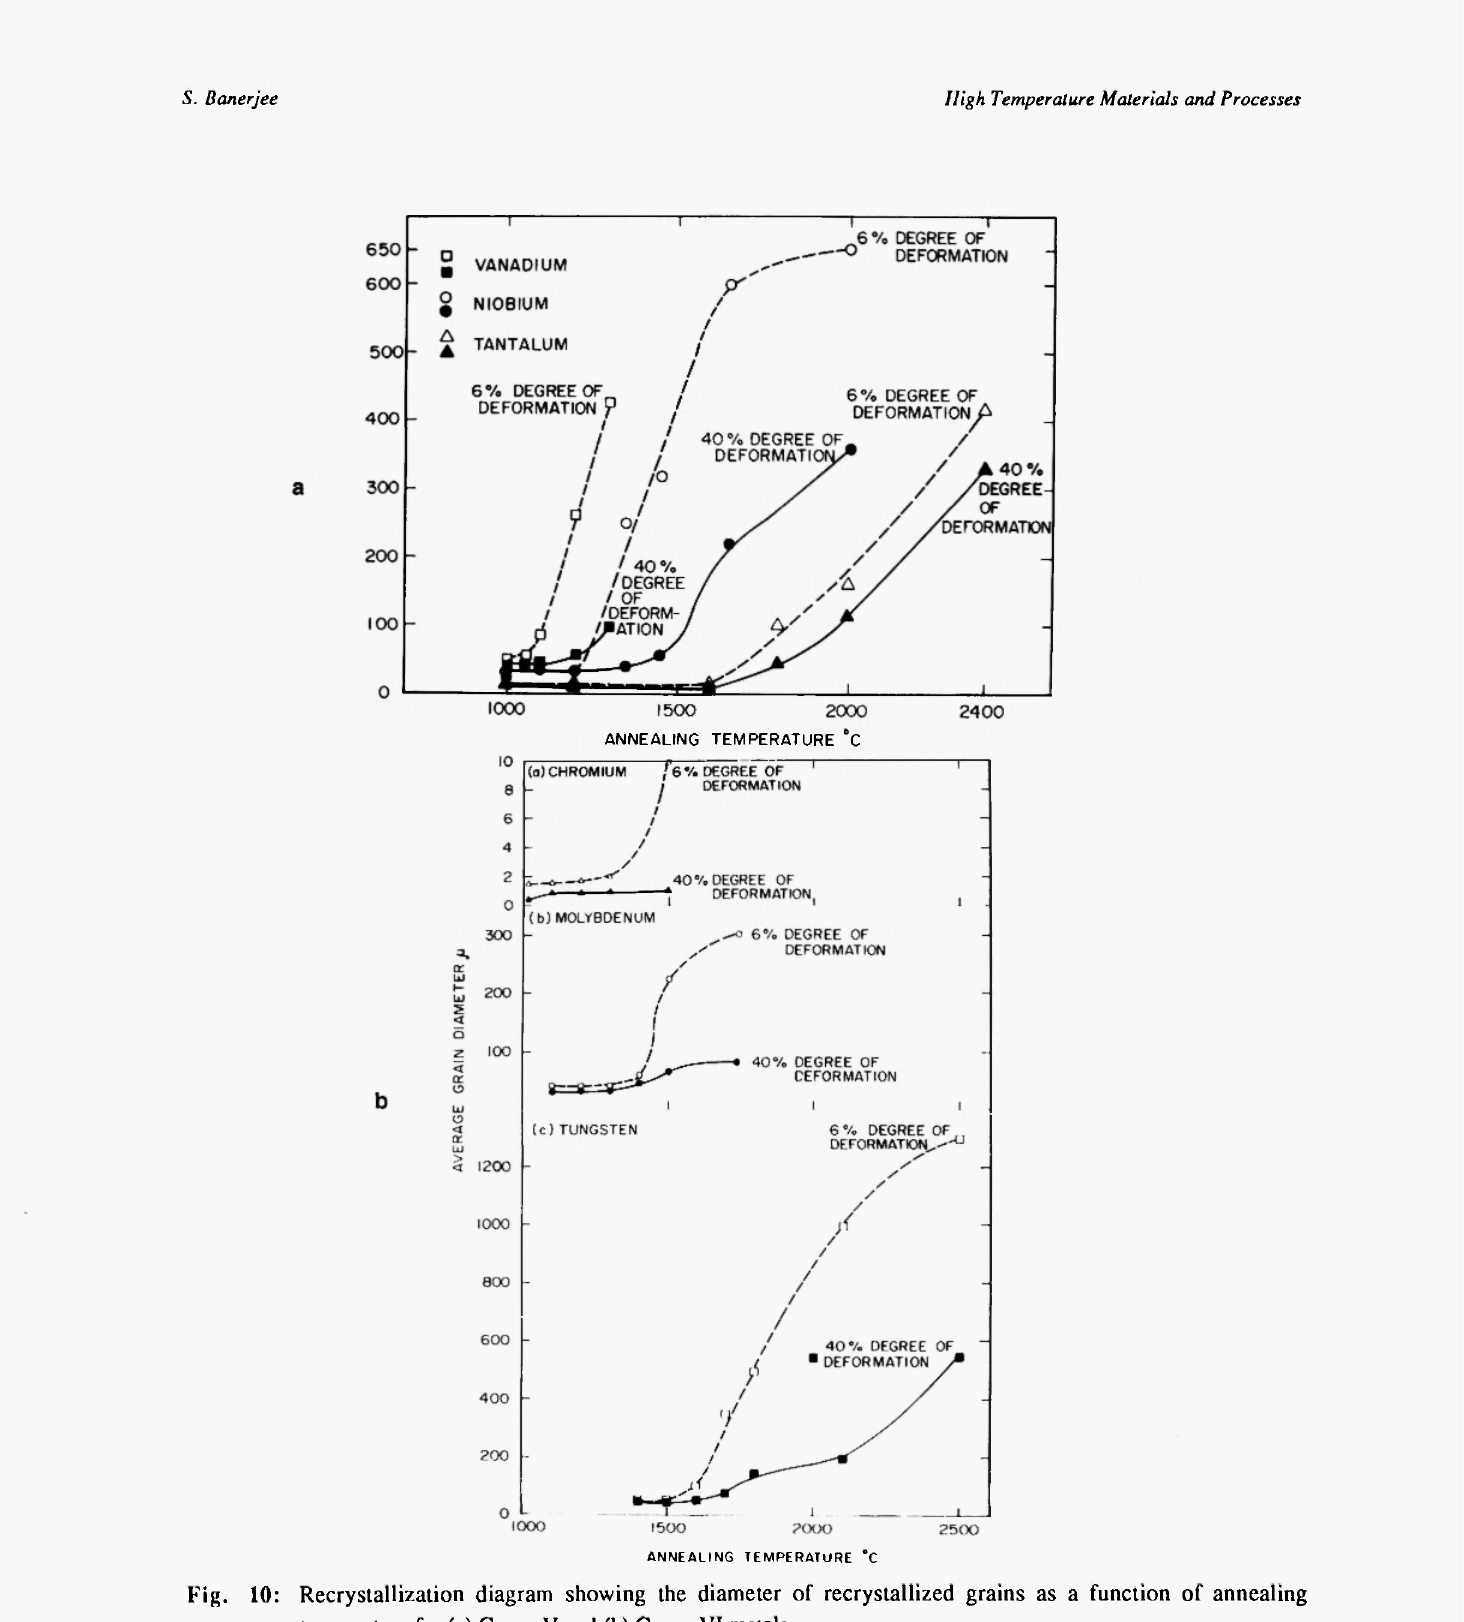
Fig. 10: Recrystallization diagram showing the diameter of recrystallized grains as a function of annealing temperature for (a) Group V and (b) Group VI